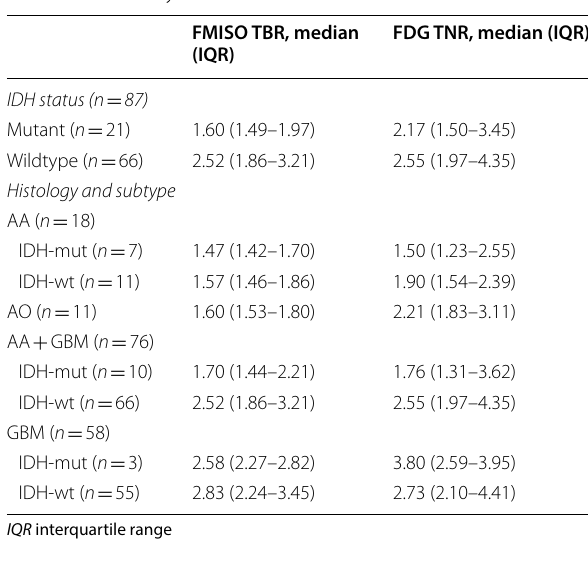
Table 2 Summary of FMISO TBRs and FDG